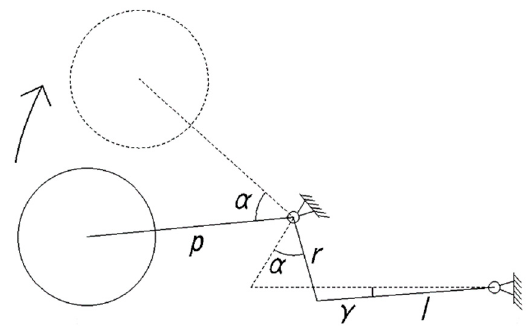
Figure 2. Height-adjusting system of the drum shearer.